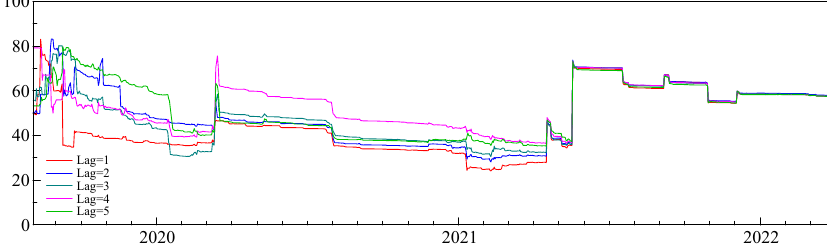
Fig. 39 Dynamic total SJV connectedness with different VAR